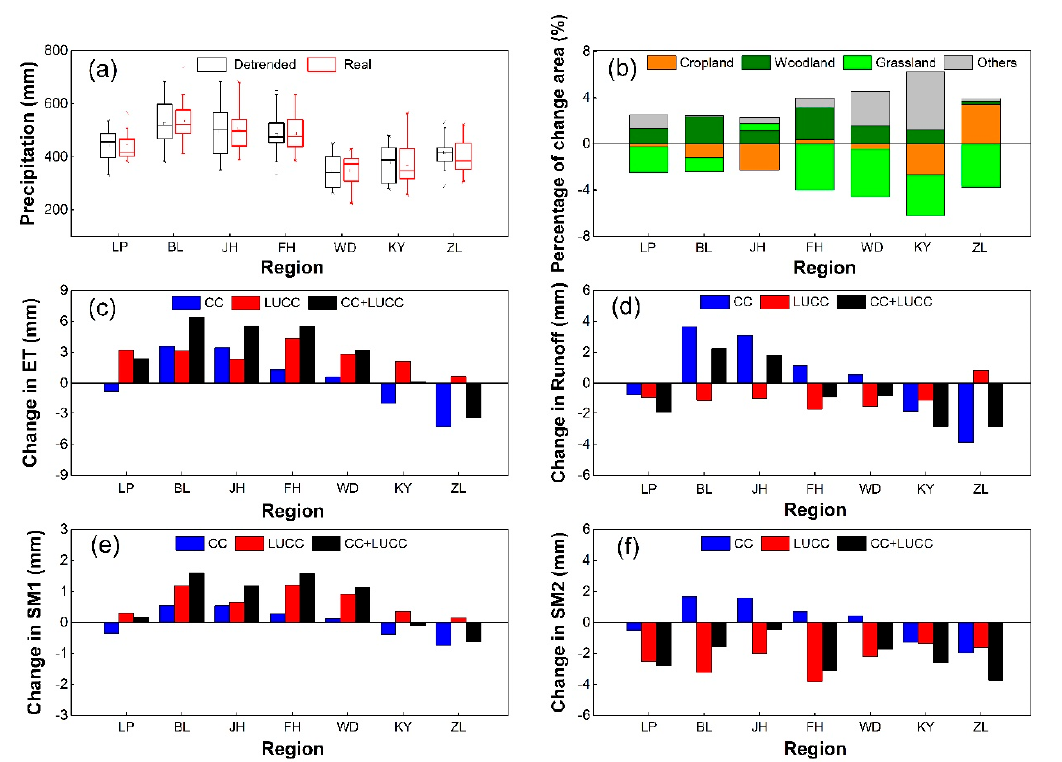
Figure 10. ( a ) Comparison of real and detrended precipitation during the period 2000–2015, ( b ) land cover change between LULC2010 and LULC1990, and variations induced by different factors in ( c ) ET, ( d ) Runoff, ( e ) SM1, ( f ) SM2 for Loess Plateau and six selected catchments during the period 2000– 2015.